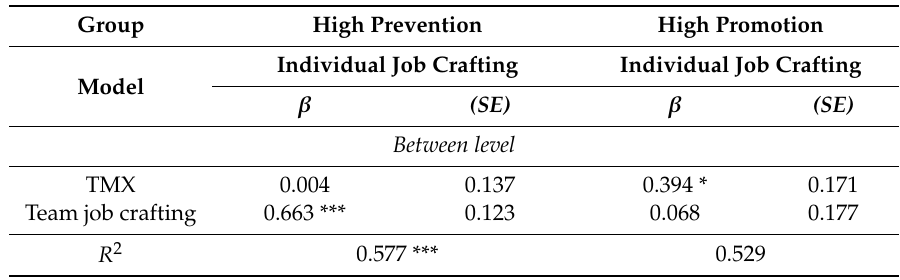
Table 12. High prevention and high promotion regulatory focus moderates the relationship between individual and team job crafting.